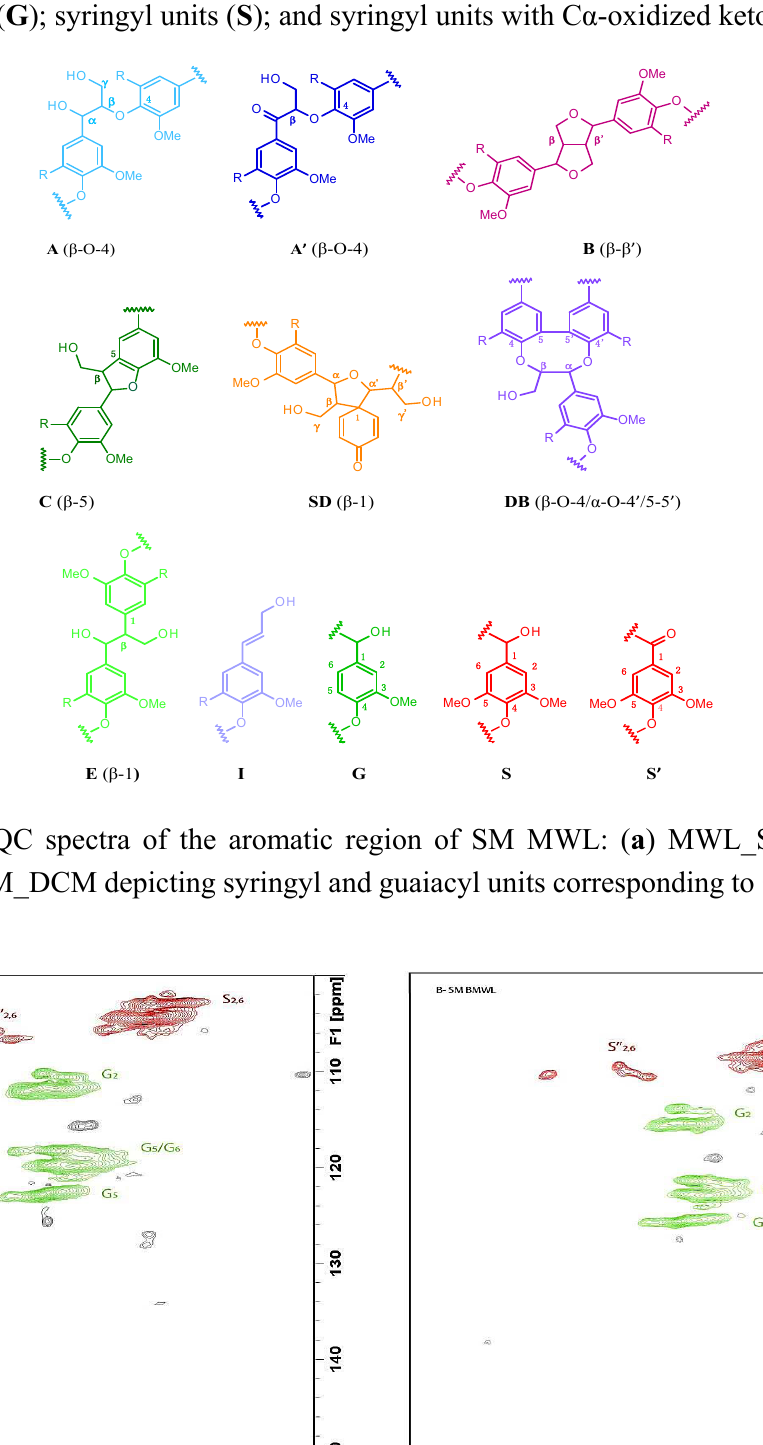
Figure 2. Structures represented in Figures 1, 3 and 4, namely β -O-4 alkyl-aryl ethers ( A ); C α - oxidized β -O-4 alkyl aryl ethers ( A ’); resinol ( B ); phenylcoumaran ( C ); spirodienone ( SD ); dibenzodioxocin ( DB ); β -1 ( E ); cinnamyl alcohol end-group ( I ); guaiacyl units ( G ); syringyl units ( S ); and syringyl units with C α -oxidized ketone ( S ’).